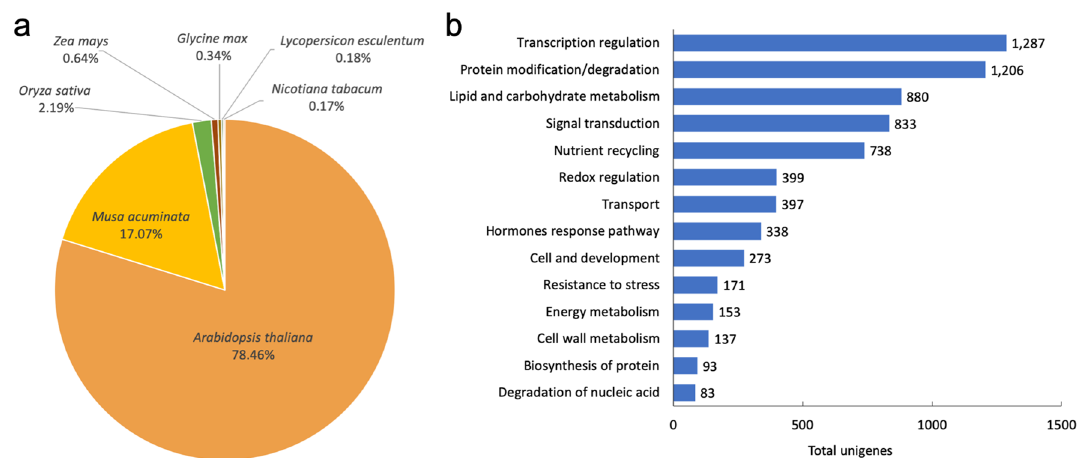
Figure 2. Annotations of Rafflesia cantleyi transcriptome data. ( a ) Species distribution of annotated Rafflesia cantleyi flower unigenes based on LSD 2.0. ( b ) Functional categories of annotated Rafflesia cantleyi flower unigenes based on LSD